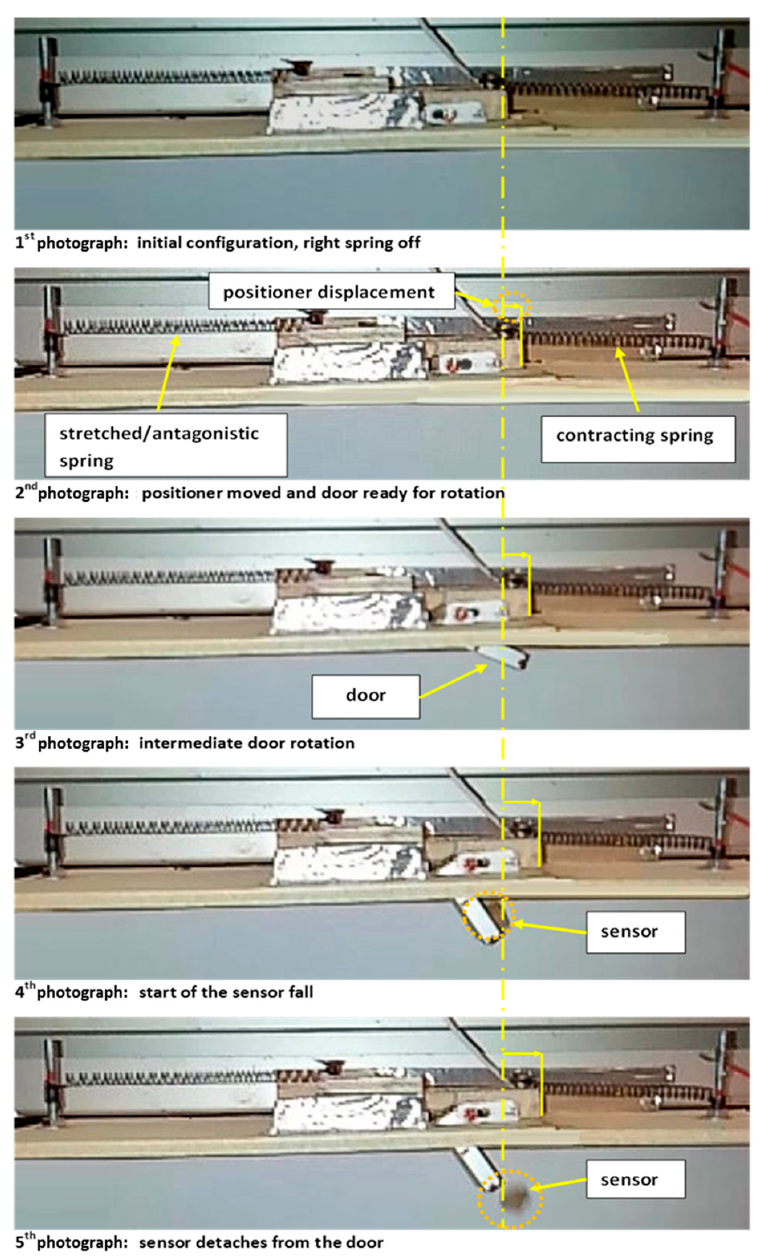
Figure 15. Photograph sequence of sensor release.